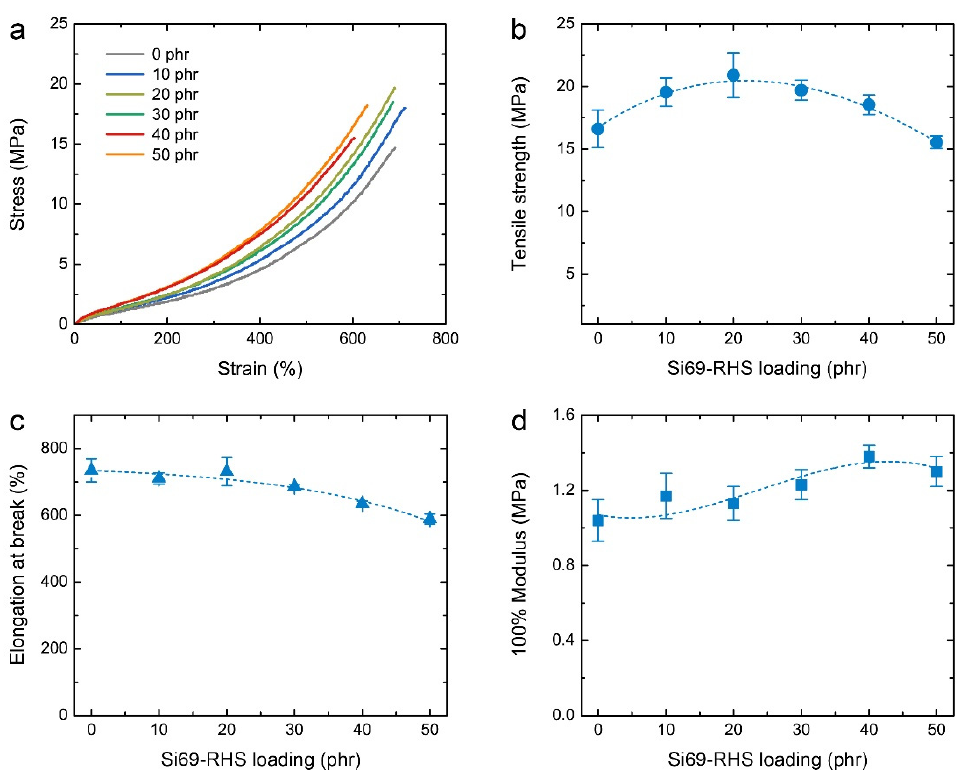
Figure 9. Mechanical properties of the NR composites filled with various Si69-RHS loadings (10–50 phr): ( a ) stress–strain curves, ( b ) tensile strength, ( c ) elongation at break, and ( d ) 100% modulus.